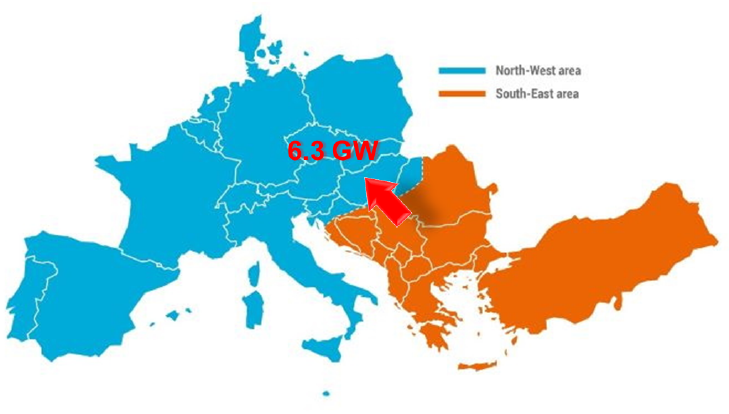
Figure 7. Separation of Continental Europe on 8 January 2021